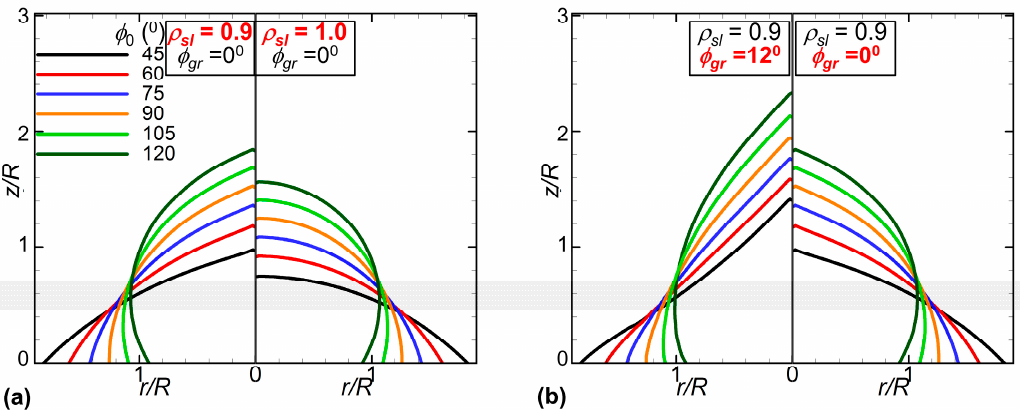
Figure 6. The solidified drop profiles for various contact angles, two density ratios ρ sl = 0.9 and ρ sl = 1.0, and two growth angles φ gr = 0° and φ gr = 12°.